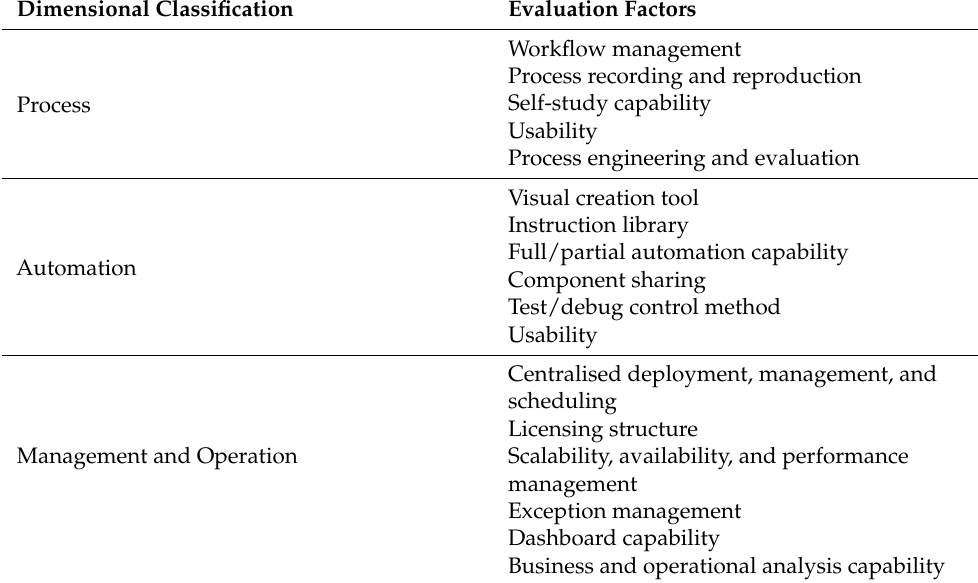
Table 1. Evaluation factors by dimensional classification of RPA product functions according to the US Federal RPA Community of Practice. Adaptation based on Ref. [25].